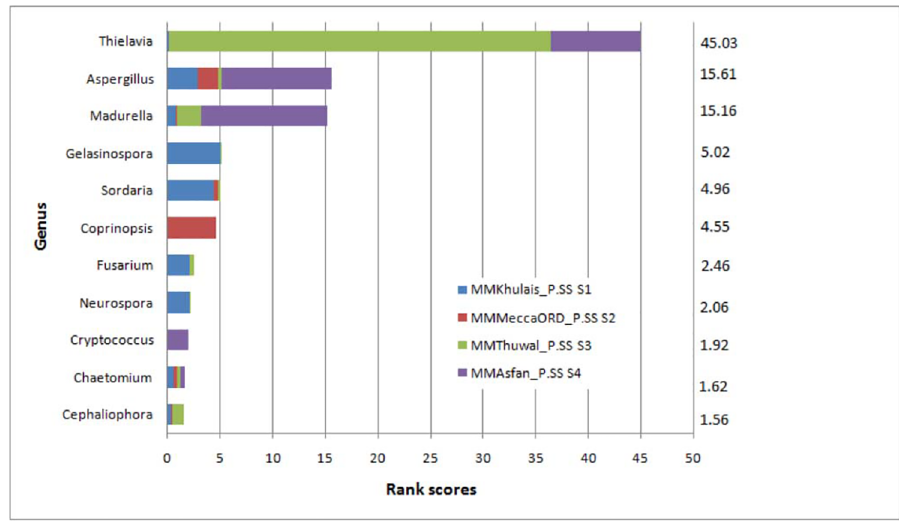
Fig 3. Bar plot of rank scores at genus